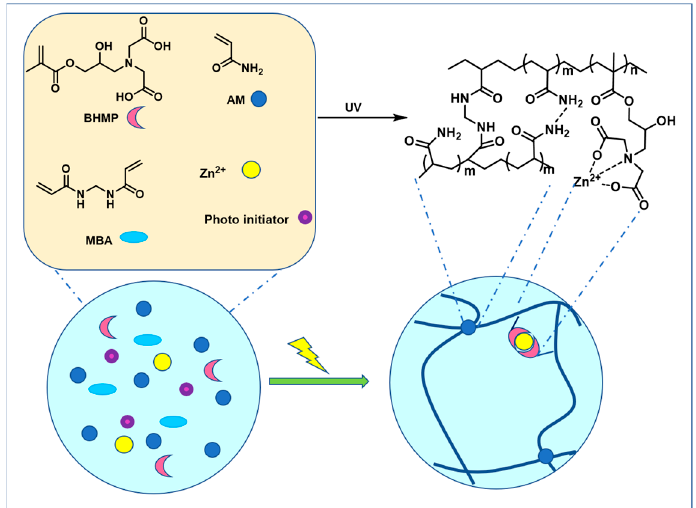
Figure 1. Preparation and network structure of the P(BHMP-AM)-Zn 2+ hydrogel.